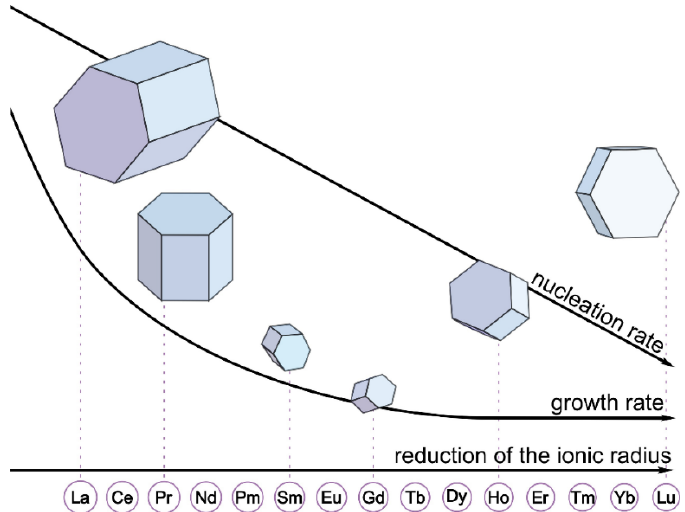
Figure 7. The effect of the crystal growth factors on the particle morphology of NaYF 4 :Ln 3+ .